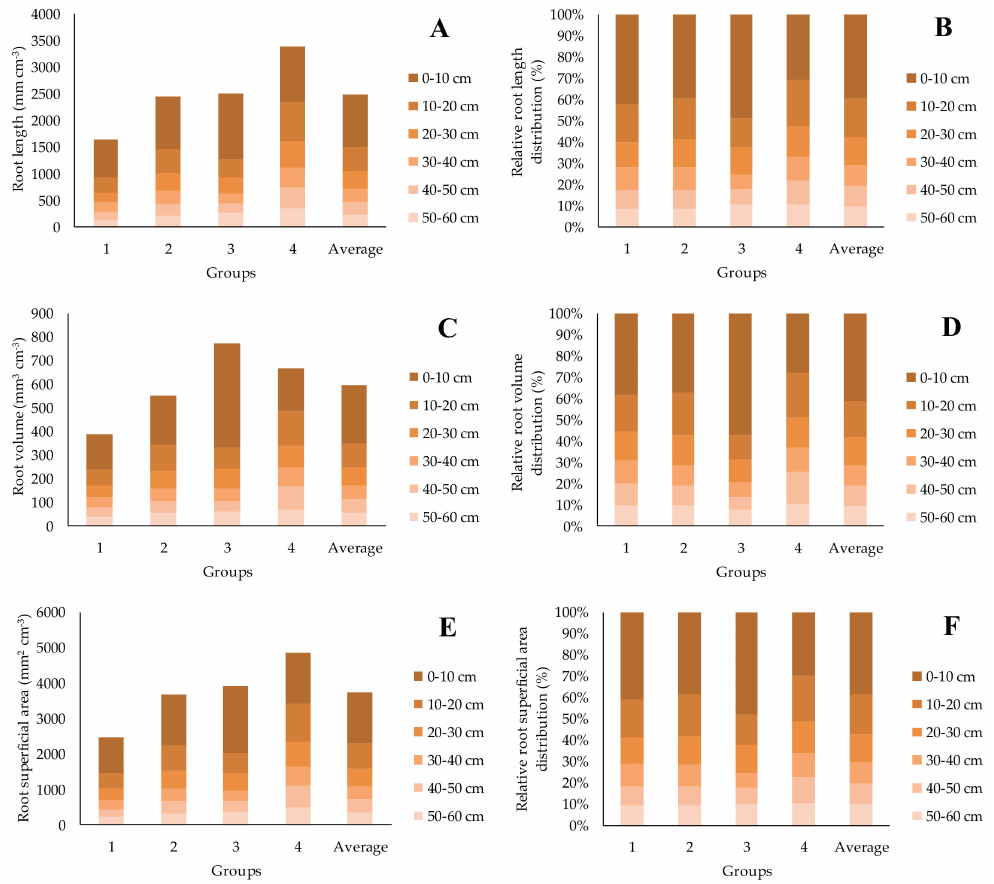
Figure 3. Mean values ( A , C , E ) and relative distribution within each group ( B , D , F ) for root length density ( A , B ), root volume ( C , D ), and root superficial area ( E , F ) in six soil depths (0–10, 10–20, 20–30, 30–40, 40–50, and 50–60